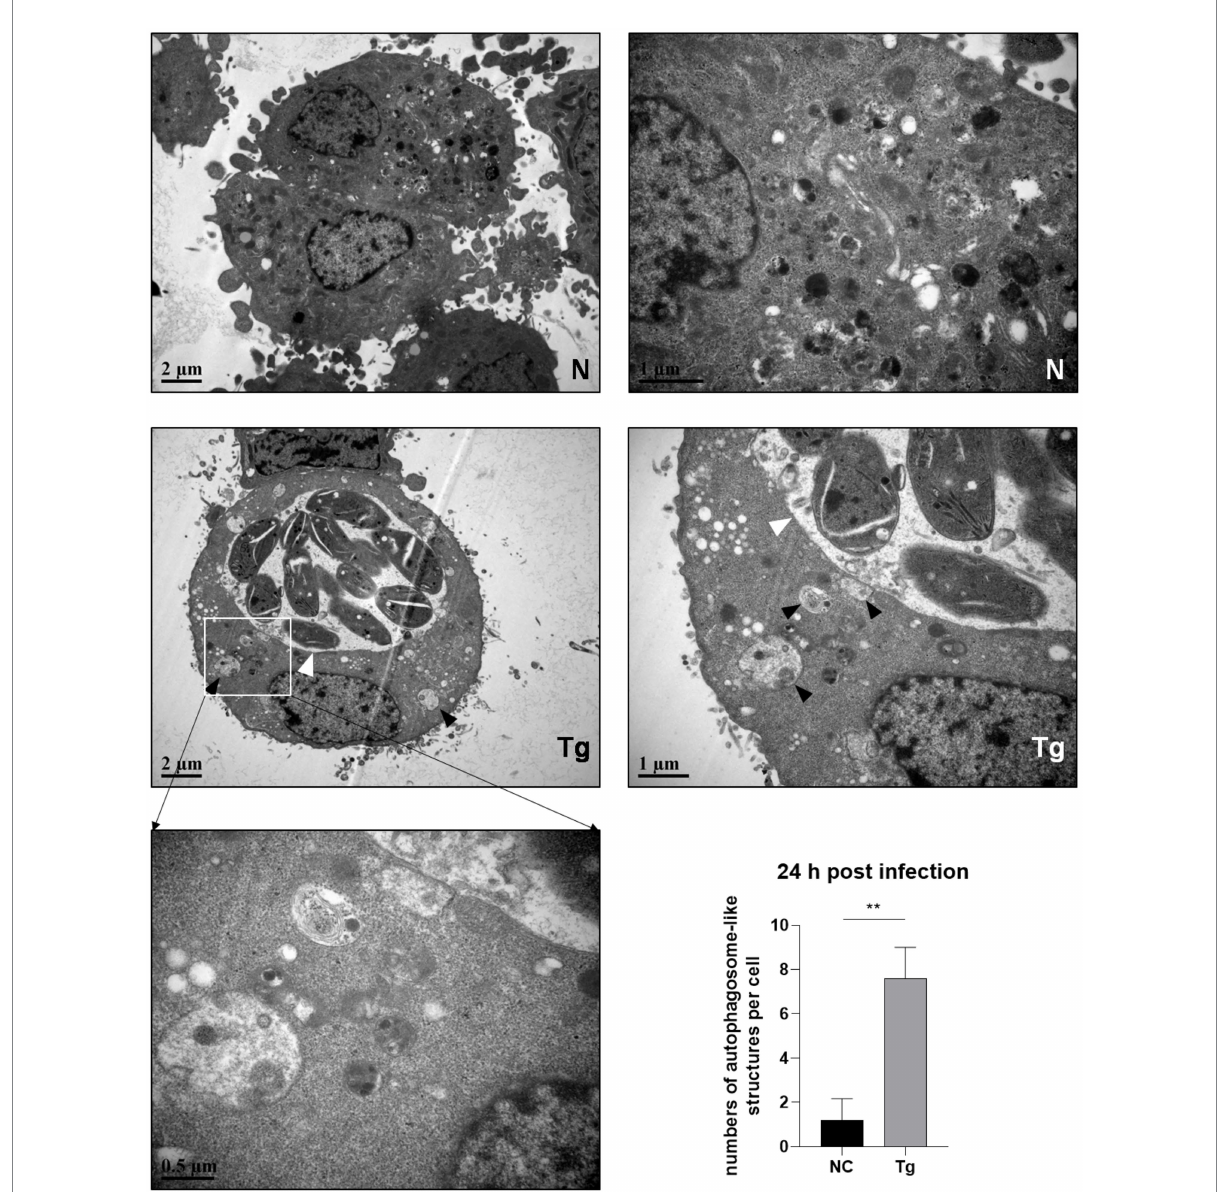
FIGURE 2 Autophagosome-like membrane structure increases in T. gondii infected cells. HeLa cells were challenged by T. gondii RH ∆ ku80 tachyzoites at an MOI of 2:1 and were fixed with 2.5% glutaraldehyde at 24 h post-infection. Autophagosome-like membrane structures (As the black arrows show) could be observed in most of the cells with T. gondii PV (As the white arrows show) (Tg), which did not exist in negative control group cells (N). The numbers of autophagosome-like structures in both groups were counted. Each value is the mean ± SEM of 5 cells (** p ≤ 0.01; t